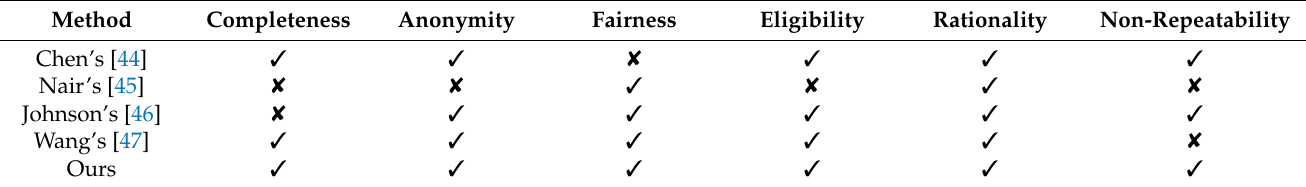
Table 9. Comparison of security